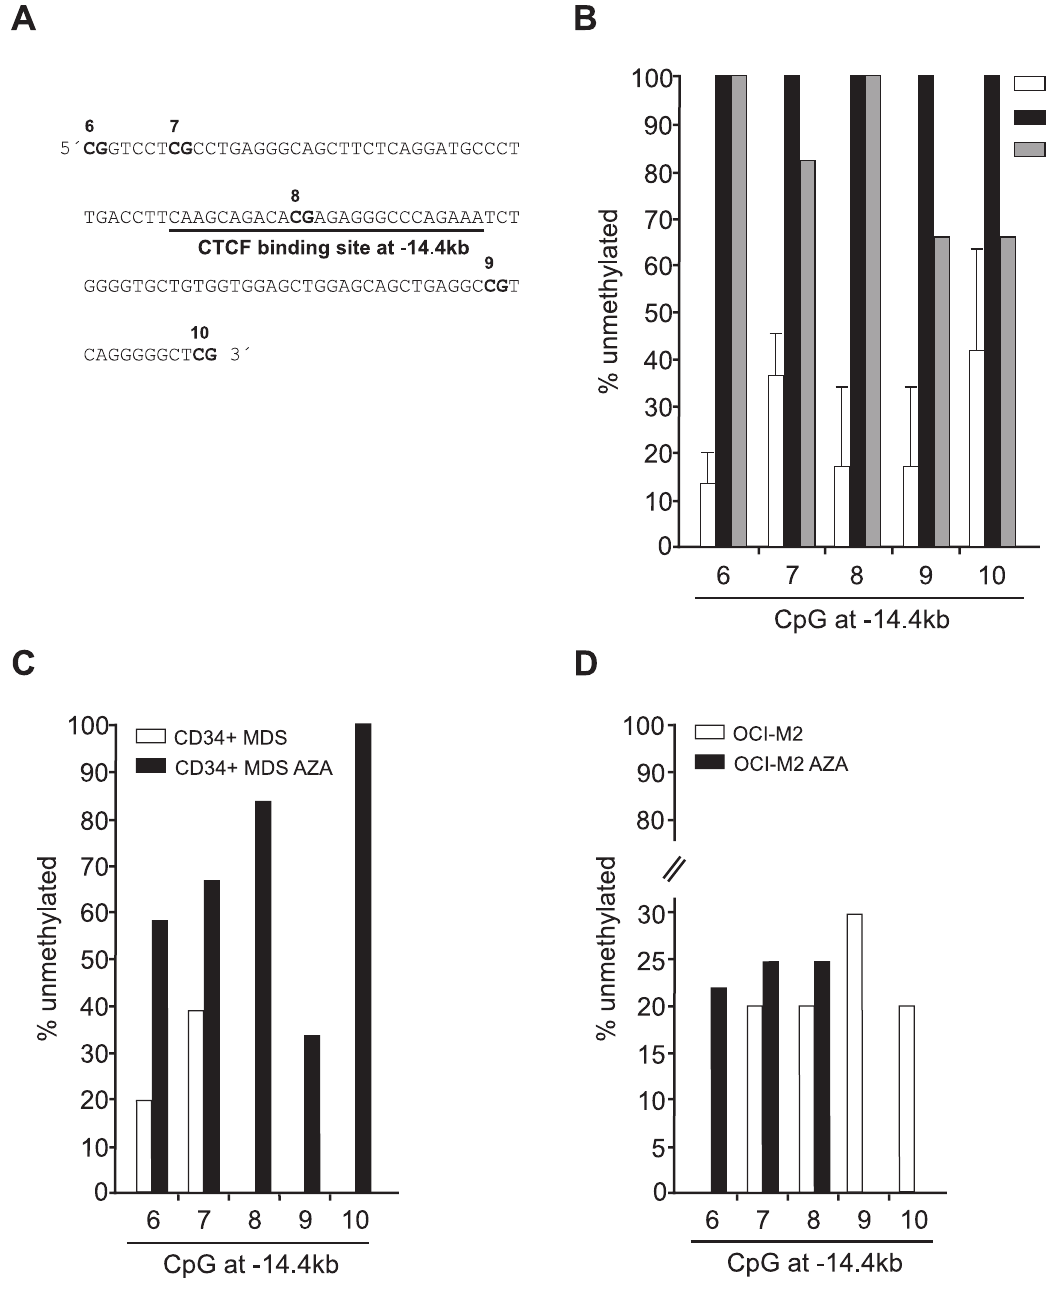
Figure 6. DNA methylation of CTCF binding site in SPI1 locus. A: DNA sequence of the CTCF binding site at 2 14.4 kb Enhancer region within the SPI1 locus (CGs are numbered on the top). B: % of DNA unmethylation identified by sequencing of bisulphite-treated DNA isolated from CD34 + cells of AML/MDS patients (N=3, information in Table S1) and control CD34 + cell donors (N=1) and mixed myeloid cells (N=1) was performed at the region 2 14.4 kb of SPI1 locus. The primer sequences are shown in Table S2. C: % of DNA unmethylation, data in CD34 + cells of MDS patient without AZA therapy (N=1) and MDS patient treated by AZA (N=1). D: % of DNA unmethylation in untreated OCI-M2 and AZA-treated OCI-M2. Y-axis: % of unmethylated CpGs; x-axis: number of CpG; error bars indicate standard